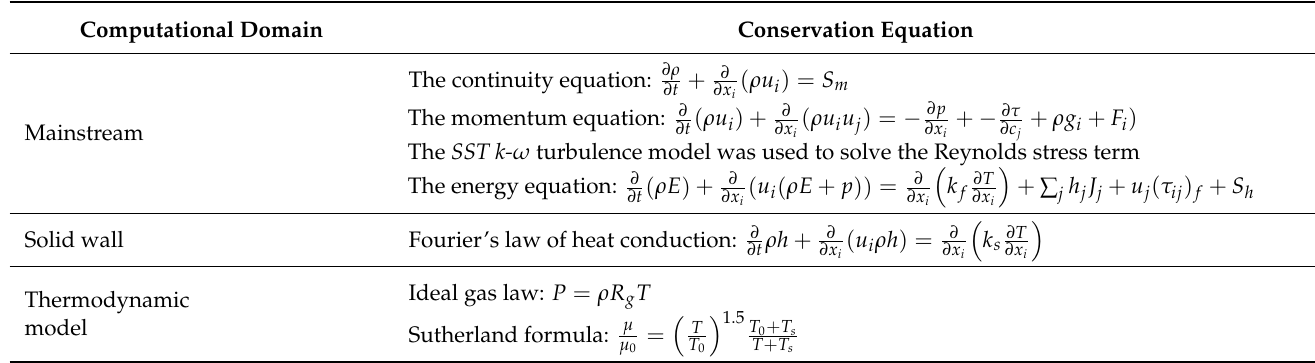
Table 3. Mathematical